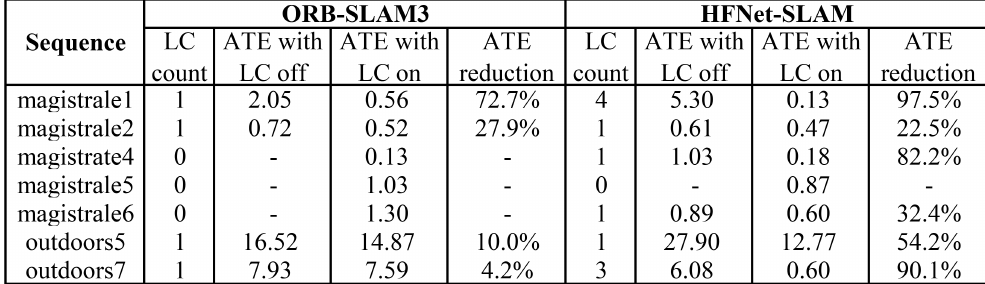
Figure 7. The comparison of loop detection modules in terms of the number of detected loops, the estimated ATE with and without loop closure, as well as corresponding error reduction (rms ATE in meters). The results are the median of five executions. The ATE errors with loop closure are provided by Figure 6.